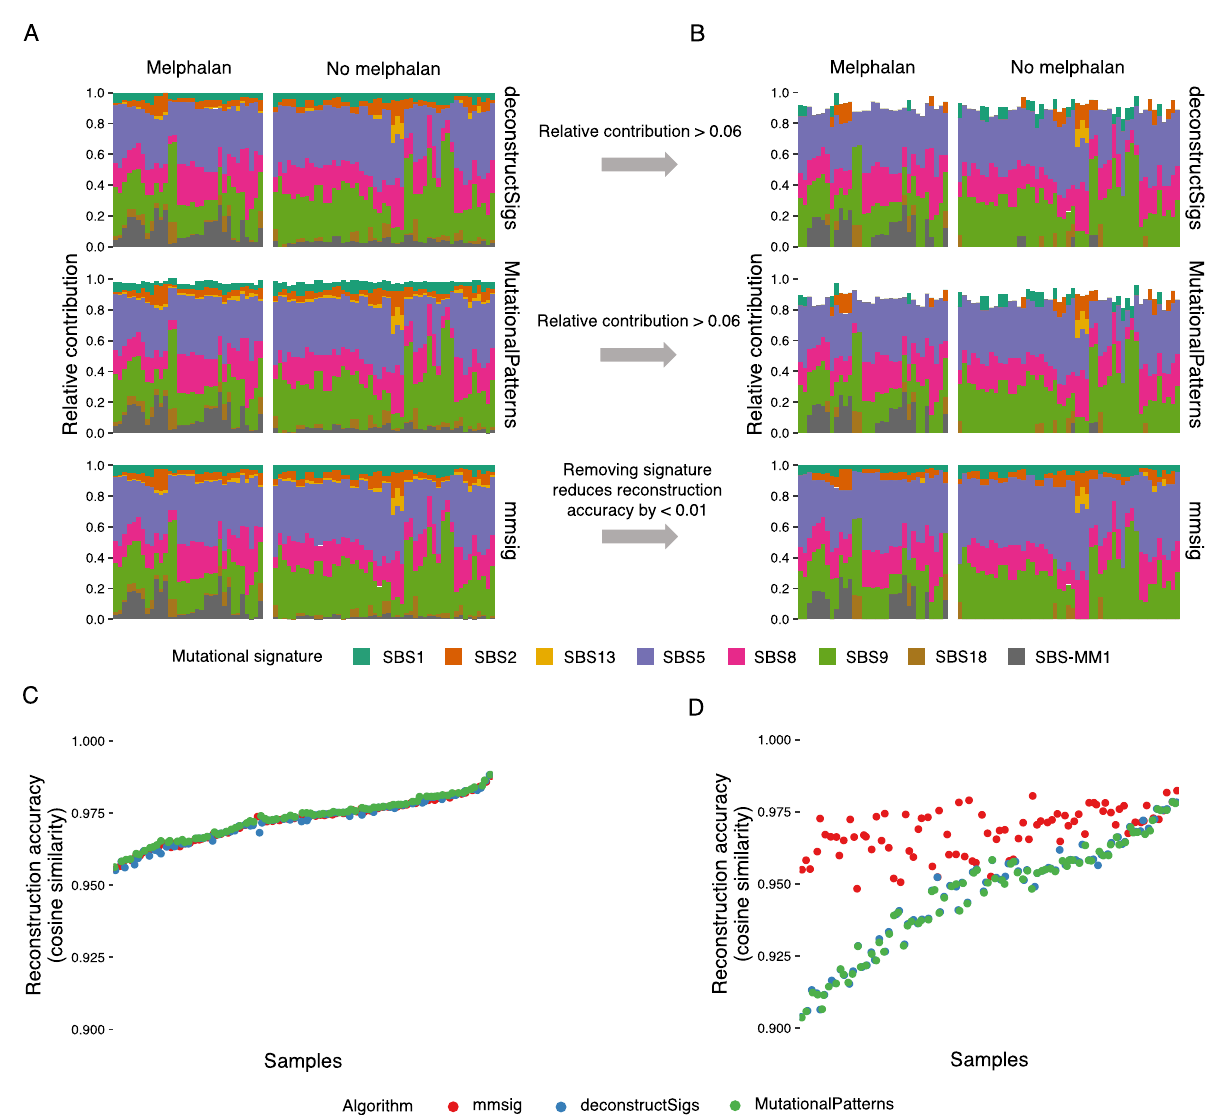
results from deconstructSigs , mutationalPatterns , and our novel algorithm mmsig are highly similar. Of note, all of the algorithms falsely identify the mutational signature of melphalan-induced mutagenesis (i.e., SBS-MM1) in >90% of patients who were not exposed to melphalan, representing false positives. B After applying the recommended fi ltering procedures, mmsig shows 100% speci fi city for SBS-MM1 while retaining the contributions from SBS1 and SBS2. Filtering of output from deconstructSigs and mutationalPattern is less fl exible, relying on a relative contribution threshold, which results in false negative SBS1 and SBS2 while retaining some cases of false positive SBS-MM1. C The reconstruction accuracy of deconstructSigs , mutationalPatterns , and mmsig are virtually identical when no fi ltering is applied. D When fi ltering procedures are applied, mmsig shows superior reconstruction accuracy >0.95